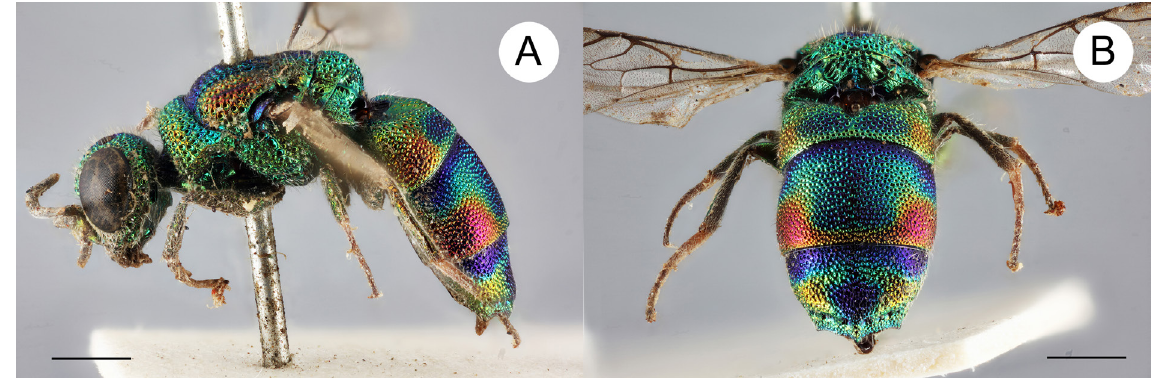
Fig. 3. Chrysis spectrum Wickar, 1908, ♀, lectotype (NHMUK). A . Habitus, lateral view. B . Habitus, posterior view. Scale bars: 1.0